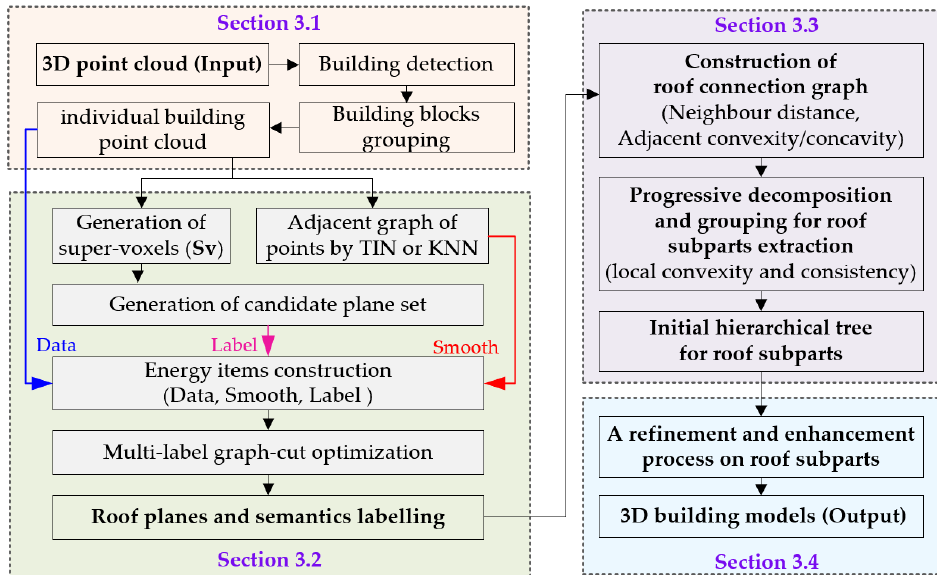
Figure 1. Methodological framework of the complete building reconstruction.